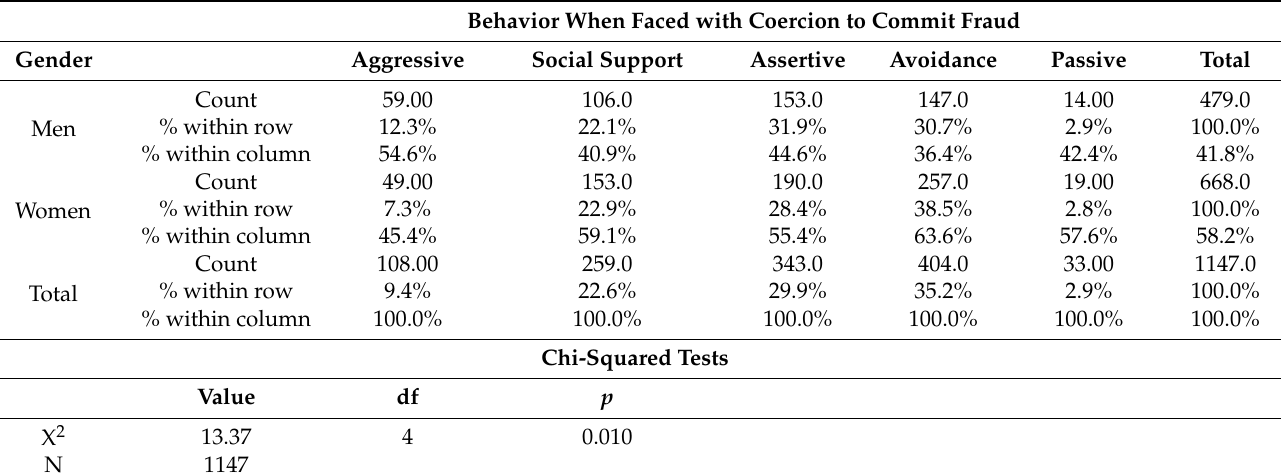
Table 1. Gender differences in the participant’s behavior when faced with coercion to commit fraud.